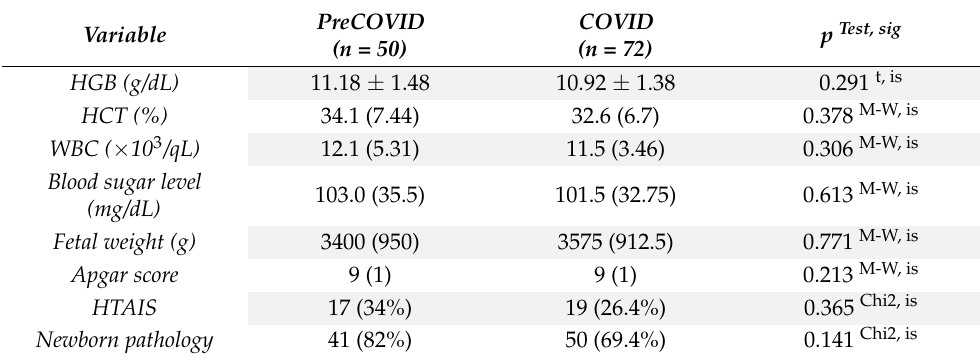
Table 4. The characteristics and results of the compared statistical